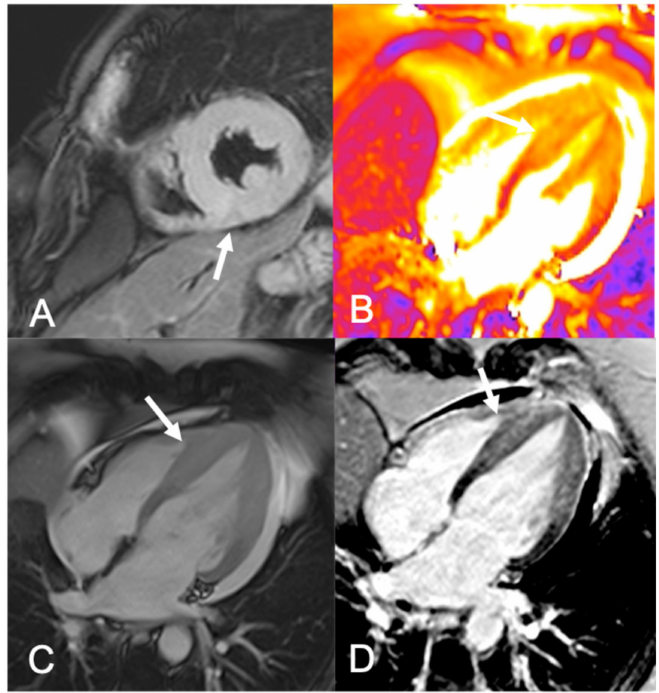
Figure 2. A 55-year-old woman on suspicion of Takotsubo syndrome. Coronarography showed no coronary stenosis. ( A ) T2-weighted short-axis image showing diffuse edema of the left ventricle middle–apical segments (arrow). ( B ) T2 mapping four-chamber view confirming the presence of edema (arrow). ( C ) Cine four-chamber TRUFI image showing thickening (arrow) of mid-apical seg- ments of the left ventricle and hypokinesia. ( D ) In the four-chamber image, there was no appreciable ischemic pattern of LGE